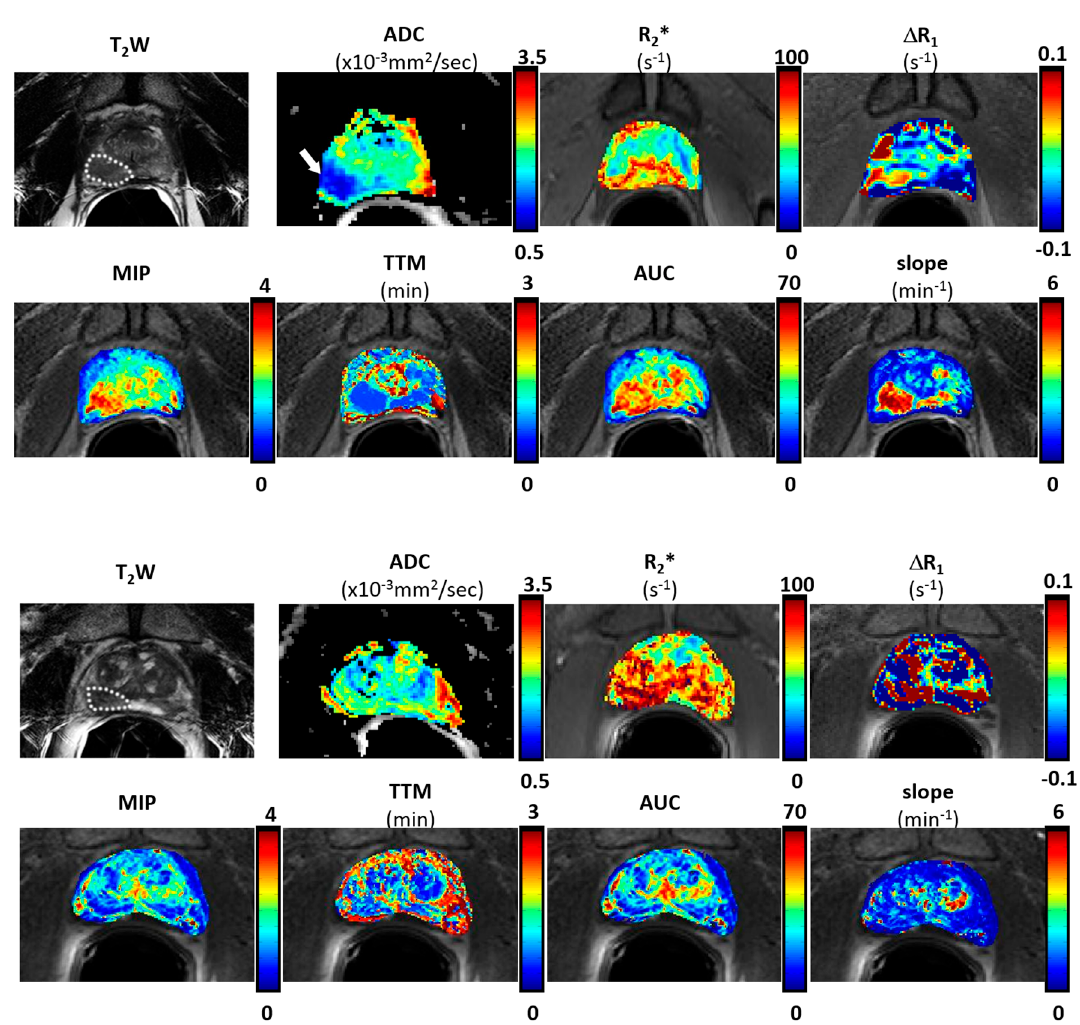
Figure 2. Multi-parametric MRI maps of two patients with Gleason score 8 (top panel) and 6 (bottom panel) tumors respectively. Parametric maps of prostate observed with endorectal coil at 3 T. For the patient with high Gleason score, the tumor region (white dotted lines) showed relatively higher values of R 2 * (air), maximum-intensity-projection (MIP), area-under-the-curve (AUC) and slope maps, while lower in apparent diffusion coefficient (ADC) and time-to-maximum (TTM) maps. No obvious difference was observed for the patient with a low Gleason score.